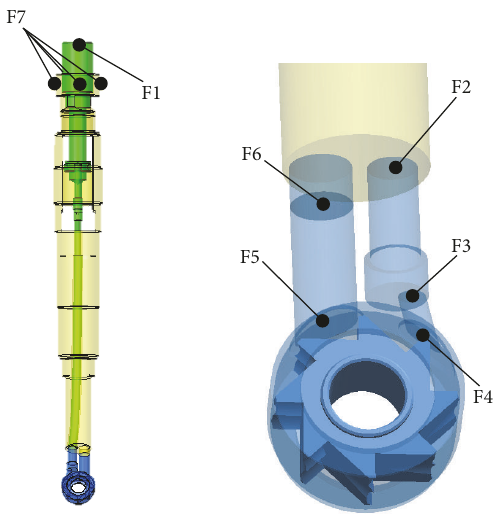
Figure 11: Measuring surface.